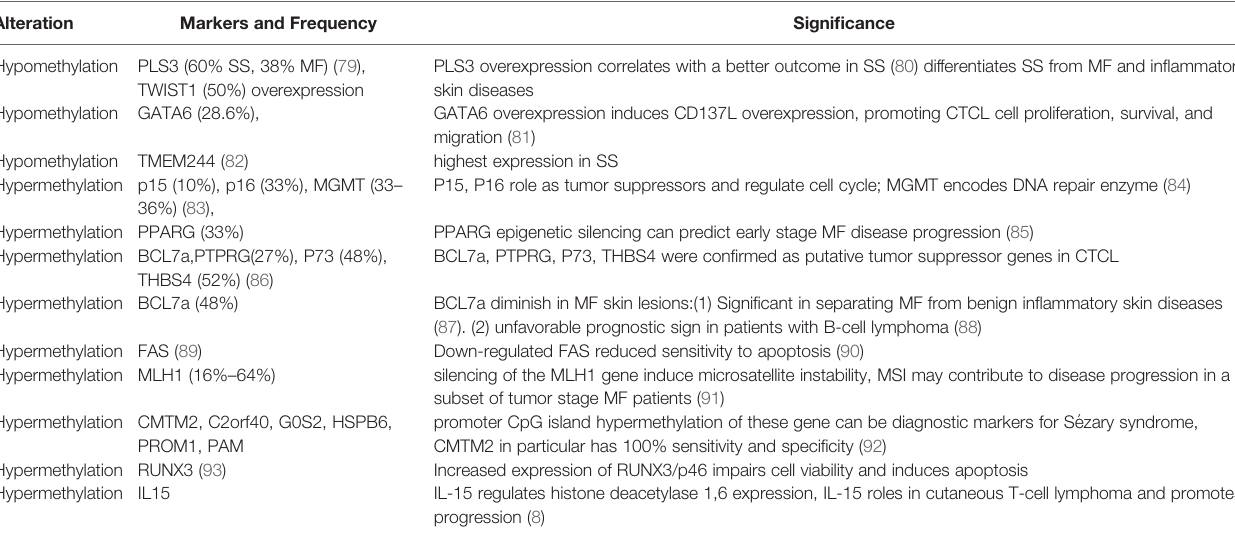
TABLE 3 | Distinct methylation gene of cutaneous T-cell lymphomas and signi fi cance [partly refer to Iz ̇ ykowska K et al. (78)]. Alteration Markers and Frequency Signi fi cance